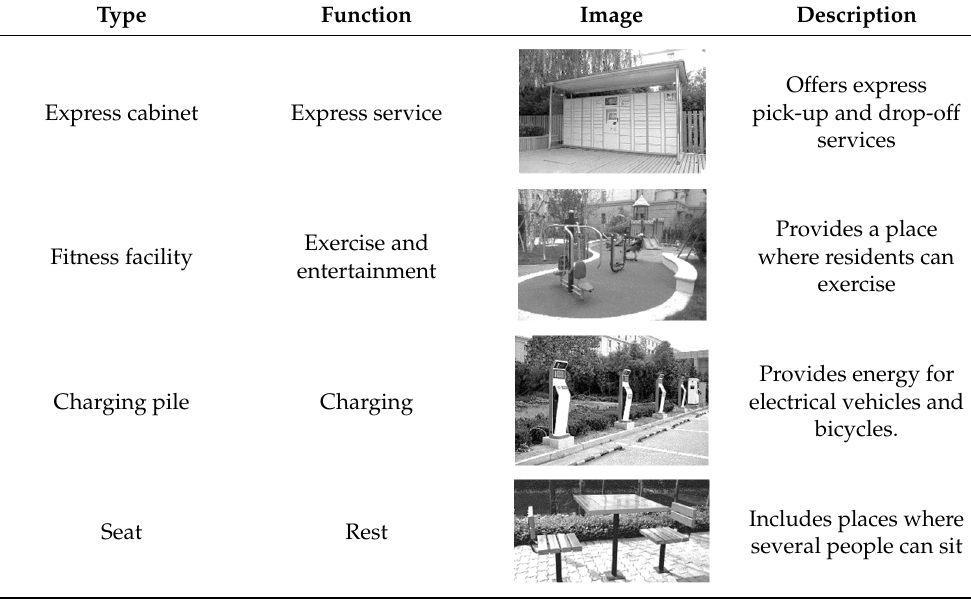
Table 1. Urban furniture in Chinese communities.